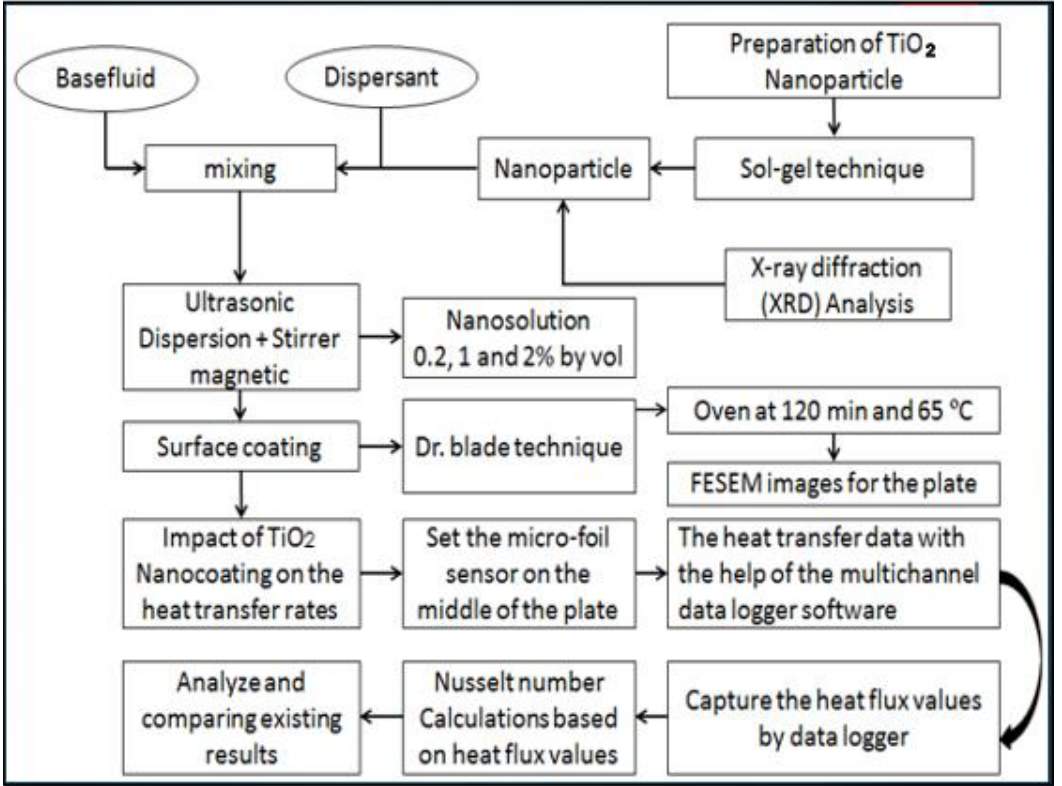
Figure 2. A typical procedure of the method in the preparation of Nano solution and experimental procedures.